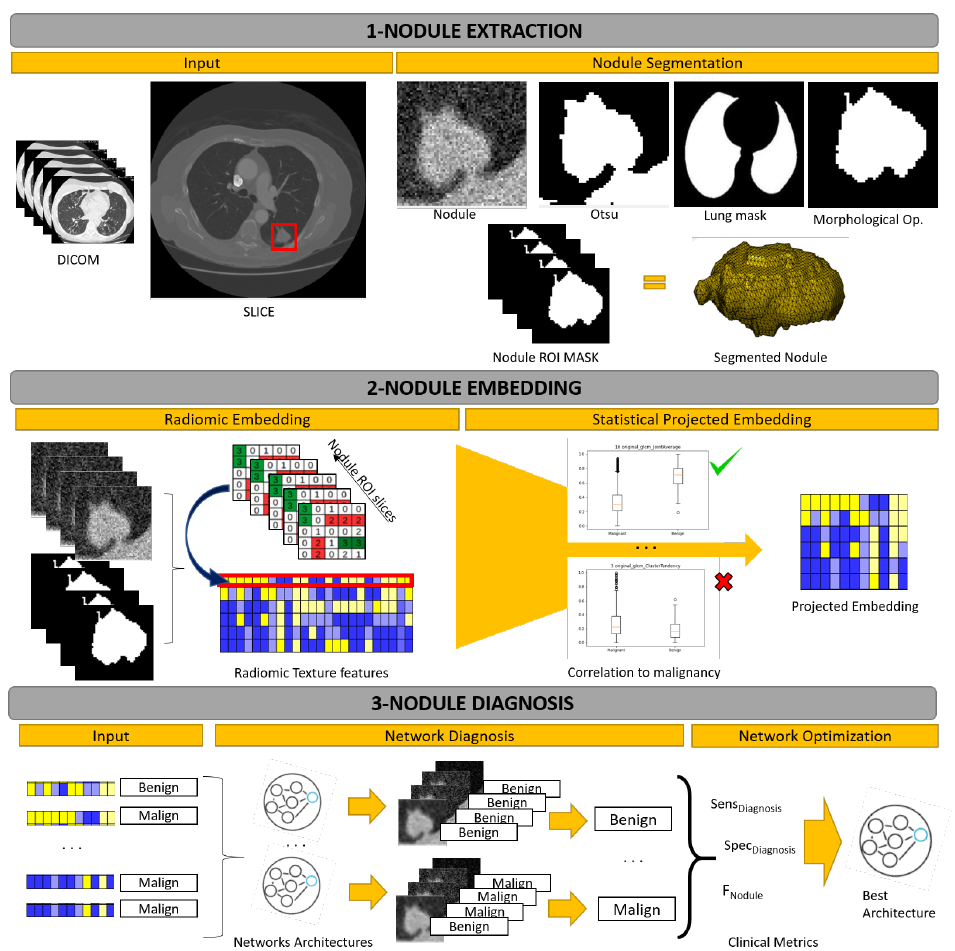
Figure 1. Overall workflow of the proposed